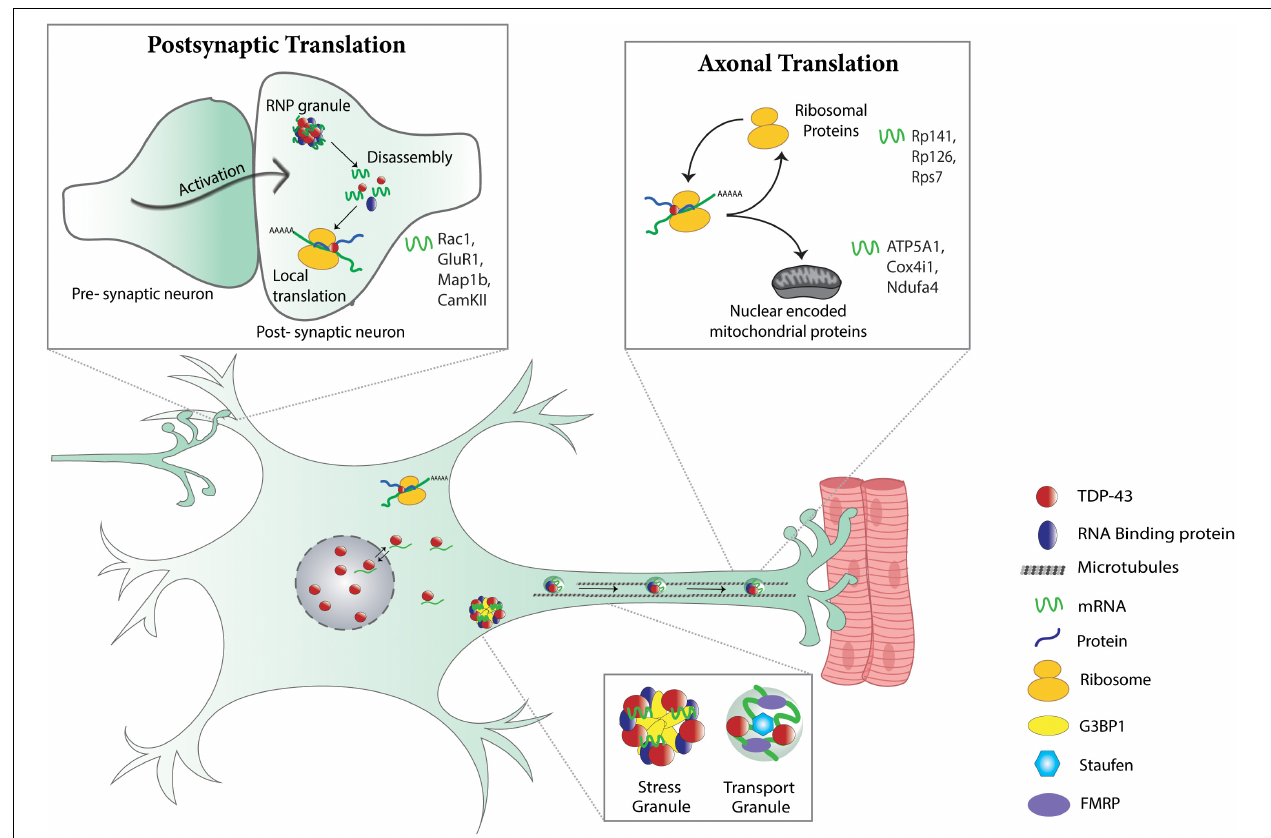
FIGURE 2 | Physiological control of local translation by TDP-43. Post-synaptic translation (top left panel): in dendrites, activation of the post-synaptic neuron triggers the dissolution of dendritic RNP granules that in turn, causes the release of translationally silenced mRNAs making them available for translation. TDP-43 is a component of dendritic RNP granules and regulates dendritic translation of various mRNAs ( Rac1, GluR1, Map1b, CamKII) (Wong et al., 2021). Stress and transport granules (bottom panel): TDP-43 associates with stress and RNA transport granules and is necessary for dendritic (Chu et al., 2019) and axonal transport (Alami et al., 2014) of mRNA-containing RNP granules. Axonal translation (top right panel): in axons, TDP-43 regulates local translation of mRNAs for ribosomal proteins ( Rp141, Rp126, Rps7 ) and nuclear encoded mitochondrial proteins ( ATP5A1, Cox4i1, Ndufa4 ) (Nagano et al., 2020; Altman et al.,